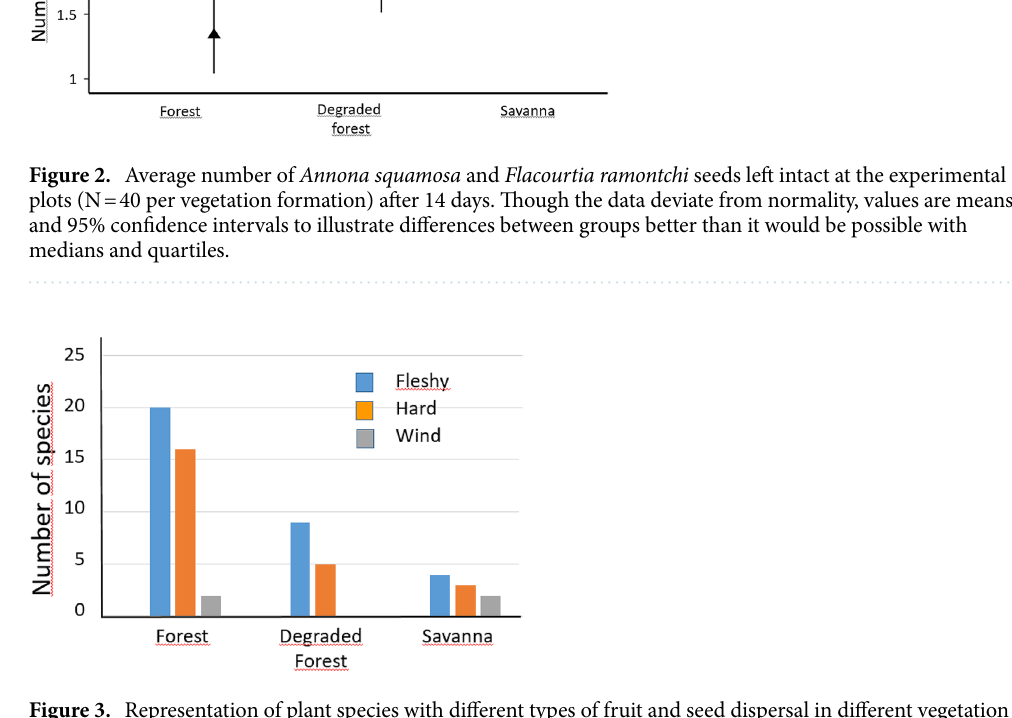
from the experimental plots, only three seeds survived until the end of the 14-day period buried in the Forest habitat. None of the seeds classified as handled in the Degraded forest and in the Savanna survived undamaged.